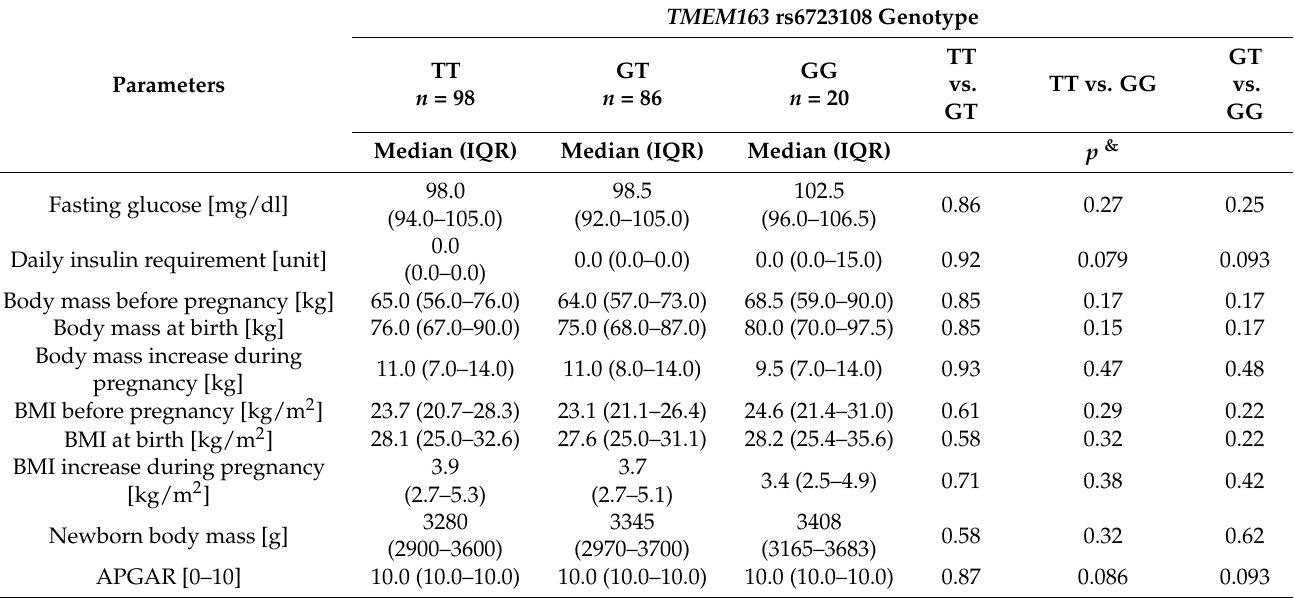
Table 3. Clinical parameters of women with GDM stratified according to TMEM163 rs672 3108